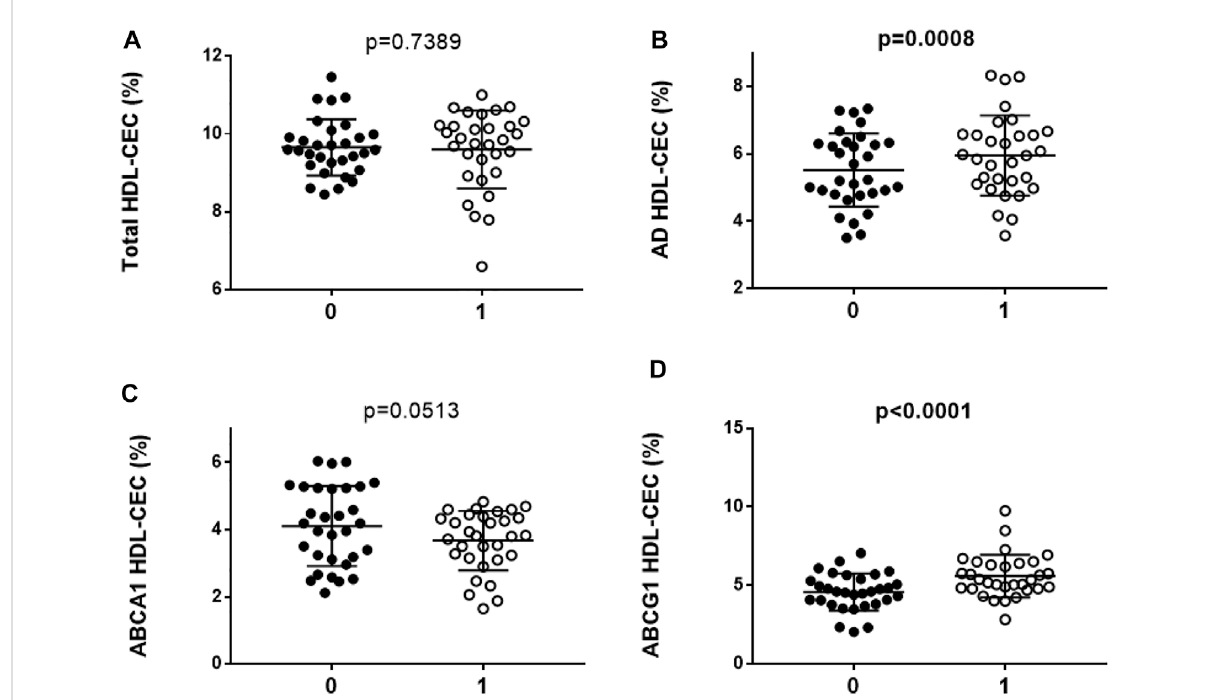
FIGURE 1 HDL cholesterol ef fl ux capacity (HDL-CEC) in FH subjects (N = 31) before and after PCSK9-i treatment. (A) : total HDL-CEC; (B) : AD HDL-CEC; (C) :ABCA1mediatedHDL-CEC; (D) :ABCG1mediatedHDL-CEC.Everydotofthegraphsrepresentsthemeanpercentageofeachtriplicateanalyses for serum sample. The horizontal line is the mean of each group. 0: FH subjects before PCSK9-i treatment; 1: FH subjects after 6 months of PCSK9-i treatment. Values in bold indicate statistically signi fi cant